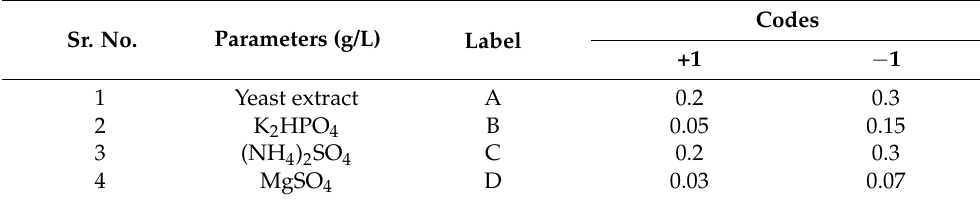
Table 1. Range of parameters used for central composite design. Sr. No. Parameters (g/L)